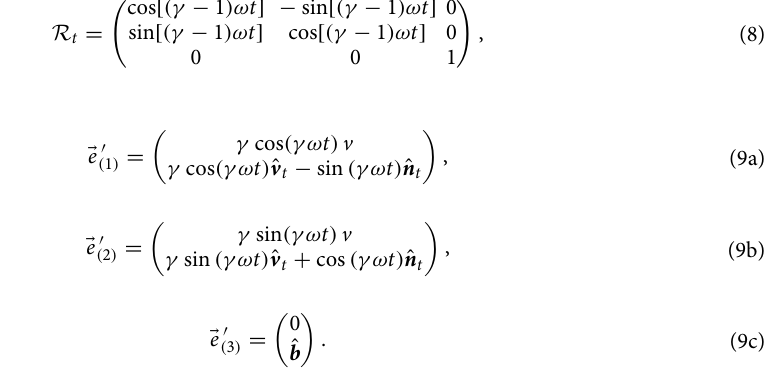
Figure 2. The parametric plot of the in-plane components T uniform circular motion, as seen from an inertial observer at the center of the motion. We used v Uniform circular motion. Let us consider the simple case of a particle, carrying an intrinsic angular momentum S , in uniform circular motion, so that γ